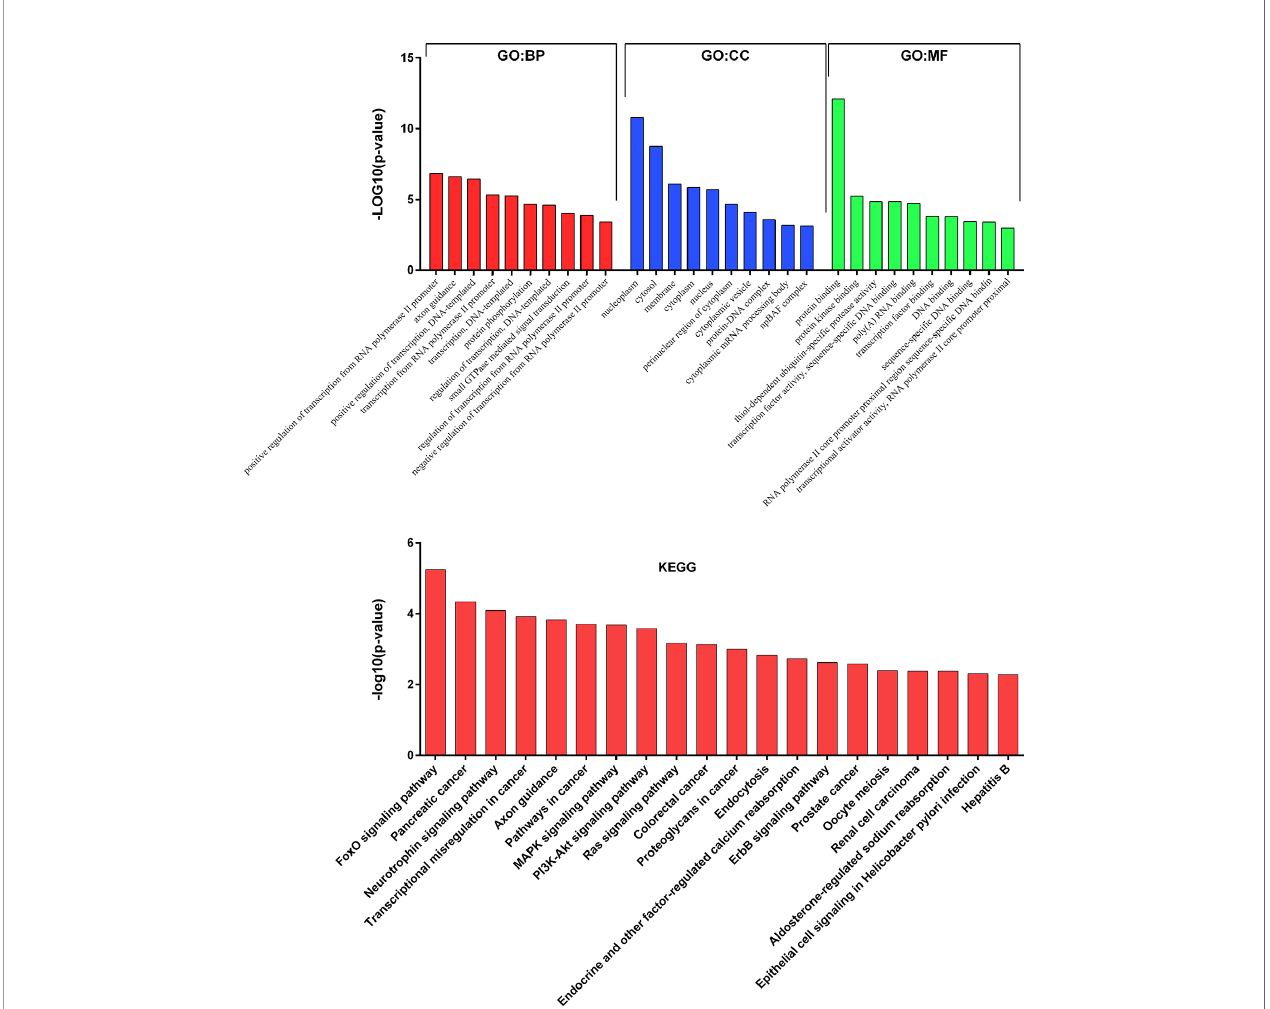
FIGURE 2 | Results of GO and KEGG pathways annotation analysis of the predicted genes targeted by the six prognostic